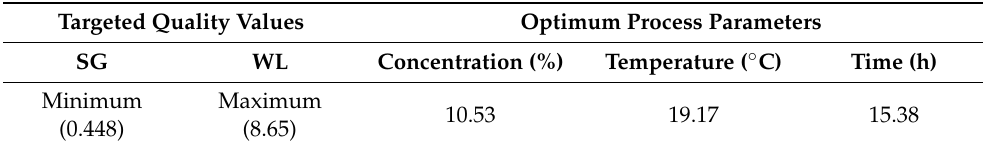
Table 4. The optimum parameters for the brining process based on the standardized quality values of brined Kimchi cabbage.